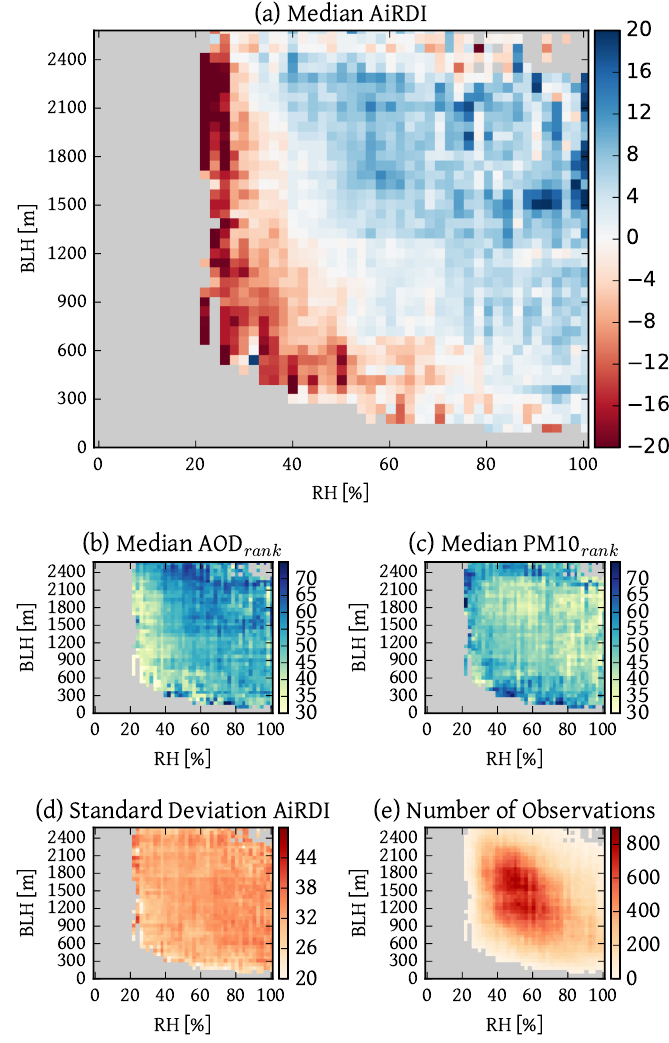
Figure 5. ( a ) Relationship between AiRDI (AOD rank − PM10 rank ), RH and BLH. BLH is gridded in steps of 60m, RH in steps of 2%, each grid cell represents the median AiRDI. ( b ) Relationship between AOD rank , RH and BLH, same grouping of RH and BLH as ( a ). ( c ) Relationship between PM10 rank , RH and BLH, same grouping of RH and BLH as ( a ). ( d ) Standard deviation of AiRDI for each class, same grouping of RH and BLH as ( a ). ( e ) Number of observations for each grid cell, same grouping of RH and BLH as ( a